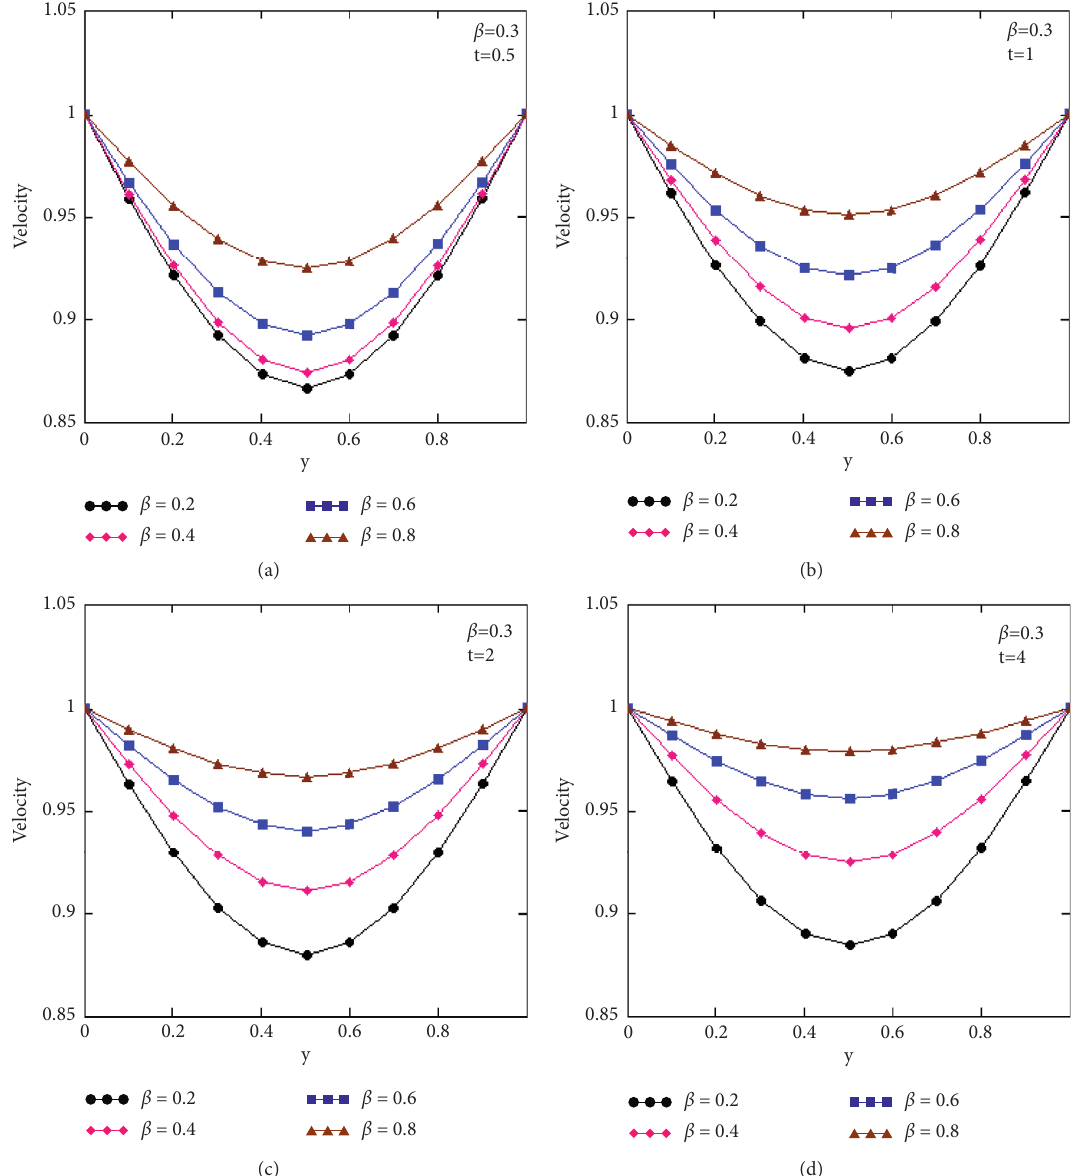
Figure 8: Profiles of dimensionless velocity versus y for variation of α at altered values of time t , Gr � 5 , λ � 2 , λ ( t ) � − H ( t ) and f and f 1